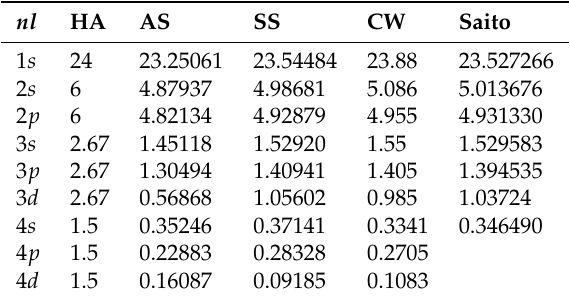
(cid:69) (cid:68) 1 calculated by the hydrogenic approximation (HA) and by the r